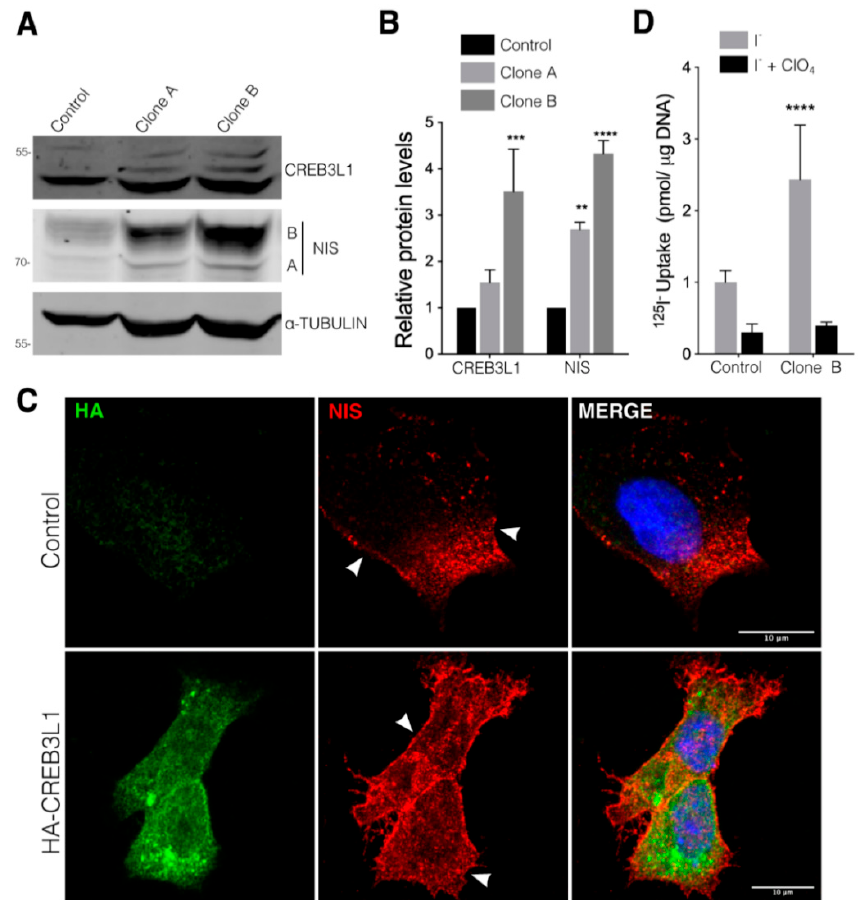
Figure 2. CREB3L1 overexpression increases NIS expression and function in thyroid cells. ( A ) Representative Western blot with antibodies against CREB3L1 and NIS of lysates from the FRTL-5 cells stably transfected with the pLenti HA-CREB3L1 vector containing the N -terminus HA-tagged CREB3L1. Two generated clones were selected for Western blot analysis (see Material and Methods for further details); in the parallel control, the cells stably transfected with the pLenti backbone vec- tor were generated. ( B ) Densitometric quantification of the proteins in A. The intensity of each band relative to α -tubulin (loading control) was measured, the values represent the fold change relative to the control cells. The results are the means ± SEM of at least three independent experiments (** p < 0.01; *** p < 0.001; **** p < 0.0001). ( C ) Confocal immunofluorescence of the Clone B cell line (HA- CREB3L1) and the control cells (incubated under growth condition) stained against HA (green) and NIS (red). The nuclei were labeled with Hoechst 33258. ( D ) 125 I-iodide transport assays assessing iodide accumulation in the vector and CREB3L1-stably expressing FRTL-5 cells under growth con- ditions. The cells were incubated with 20 μ M iodide in the absence (gray bars) or presence (black bars) of 80 μ M K-perchlorate. The data are expressed in pmol of 125 I-iodide/ μ g of DNA. The values represent the fold change relative to the control cells incubated with 125 I-iodide the absence of per- chlorate. Statistical analysis was performed between the Clone B cells and the control cells incubated with 125 I-iodide in the absence of perchlorate. The results are the means ± SEM of three independent experiments (**** p < 0.0001) Furthermore, immunofluorescence analysis performed in the FRTL-5 cells express- ing HA-CREB3L1 revealed that NIS expression increases in both the ER and the plasma membrane (Figure 2C, arrowheads). It is noteworthy to mention that the CREB3L1 immu- nofluorescence signal corresponds to HA-CREB3L1 located in both the ER (full length) and the nucleus (active), while Western blot assays only display the active fraction. To correlate NIS expression with its ability to transport iodide, 125 I-iodide uptake assays were performed in the HA-CREB3L1-expressing cells (Figure 2D, Clone B) in the presence and